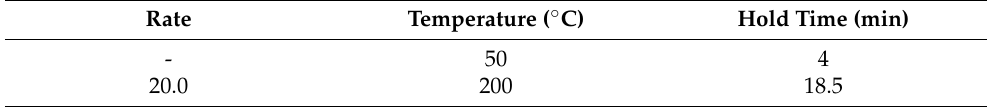
Table A1. Column Oven Temperature Table A1 Column Oven Temperature Program.